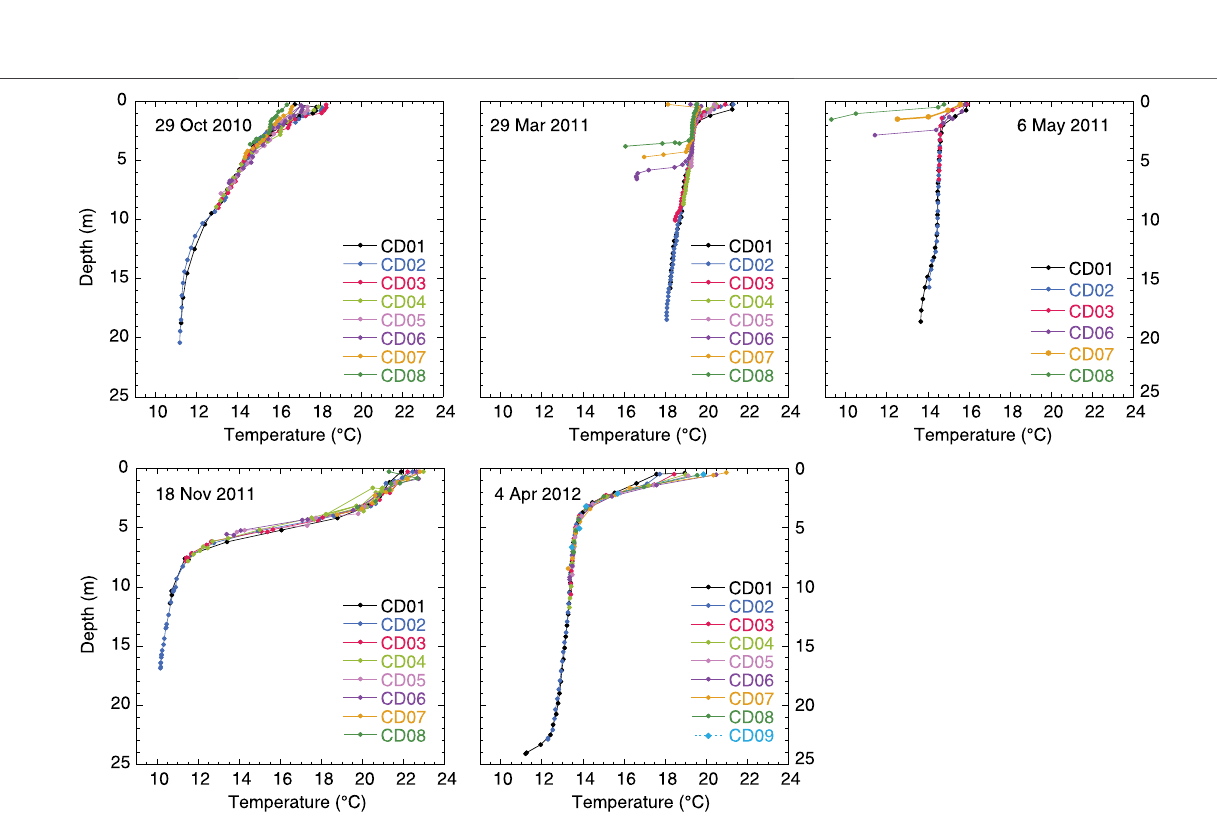
Frontiers in Environmental Science |